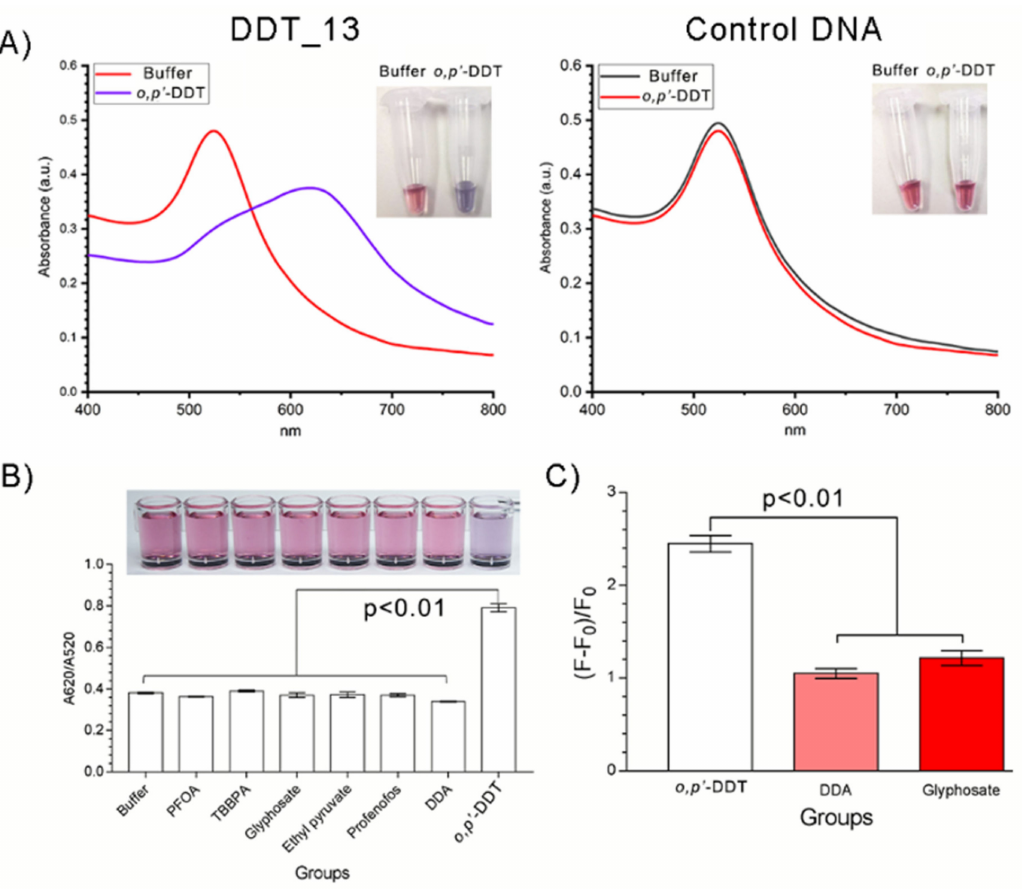
Figure 6. Analysis of selectivity of DDT_13. ( A ) The signal changing induced by control DNA or the DDT_13; ( B ) Signal changing of DDT_13 specifically responded to o,p’ -DDT but not to other kinds of small molecules; ( C ) Fluorescence response to o,p’ -DDT and other small